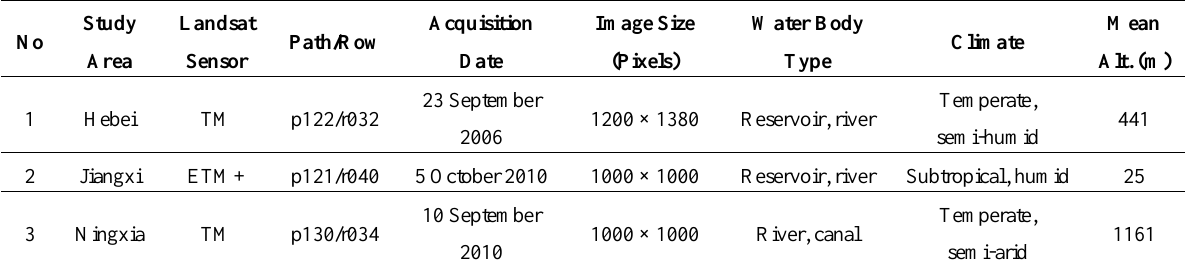
Table 1. Summary of the study areas and input Landsat images. Alt: